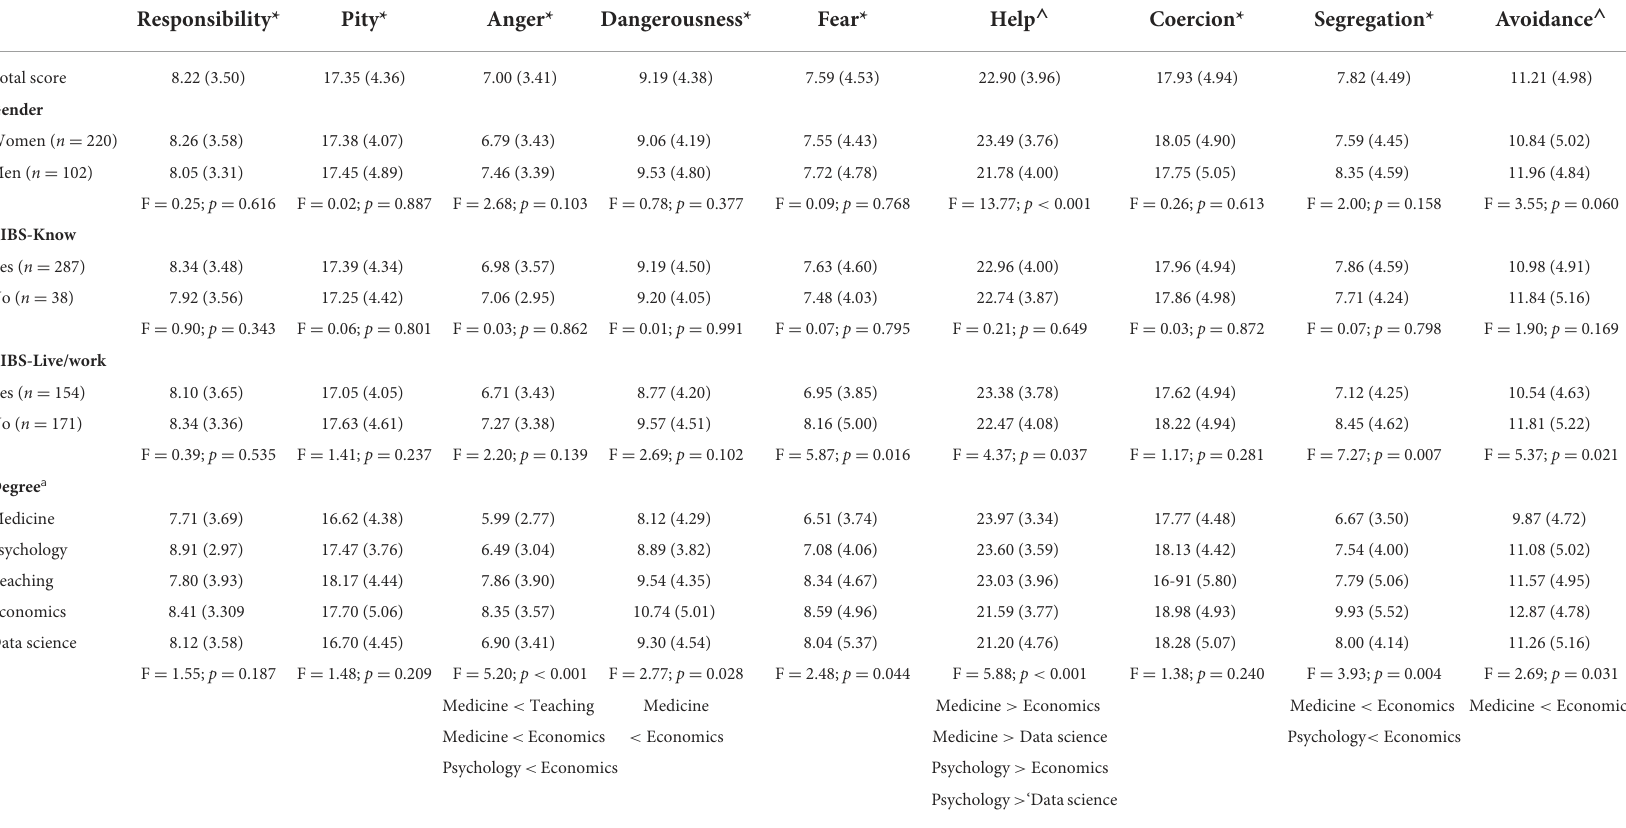
TABLE 4 Means and standard deviations in the AQ-27